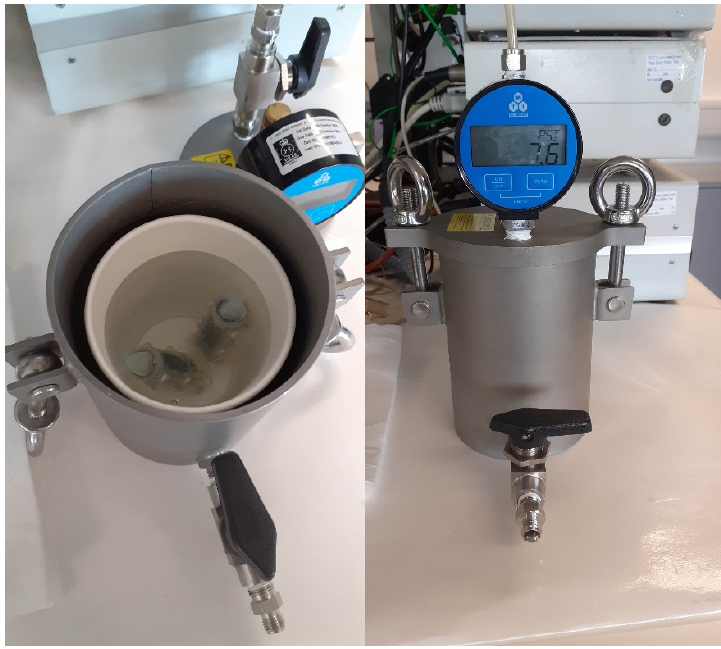
Figure 15. Test setup for the pressure sensor test in water.